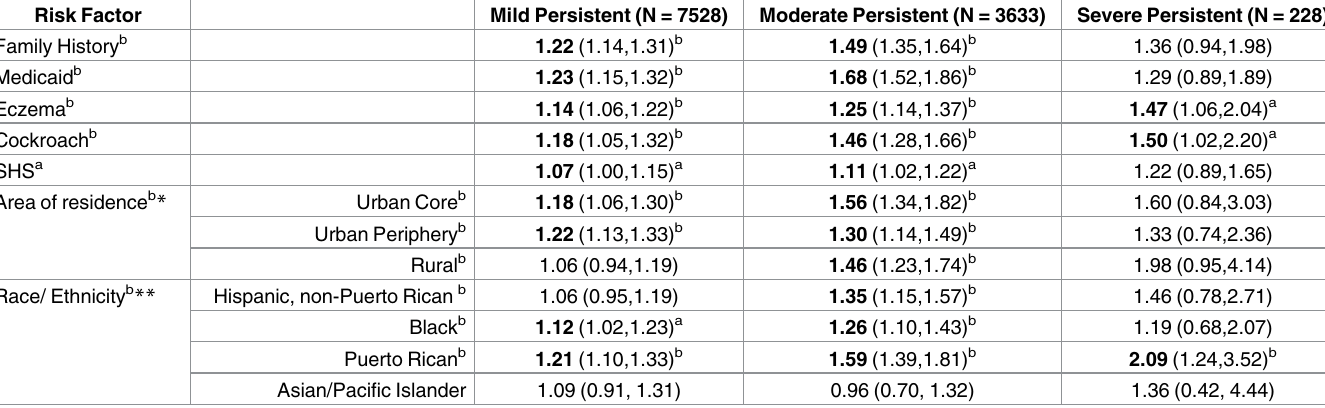
Table 4. Main Effects Analysis on Asthma Severity using Multinomial Logistic Regression with Multiple Imputation (N =